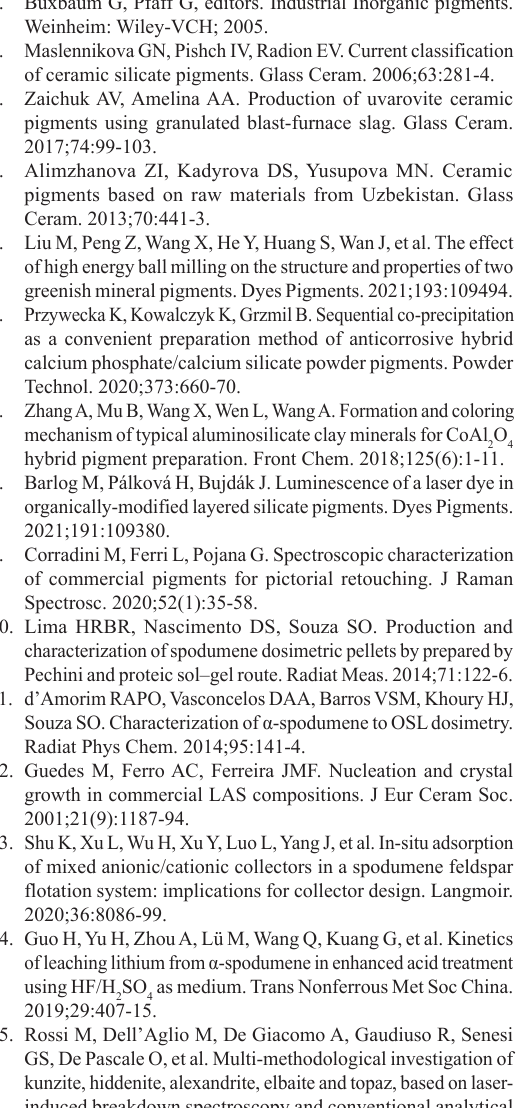
O :Cr samples. 2 6